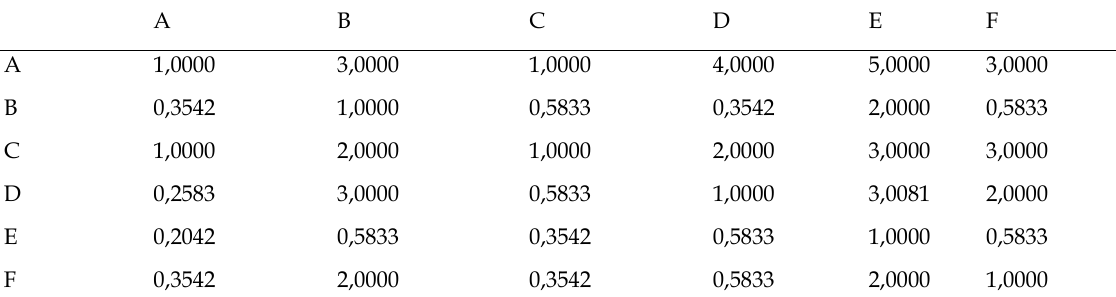
The evaluated pairwise comparison matrix A B C D